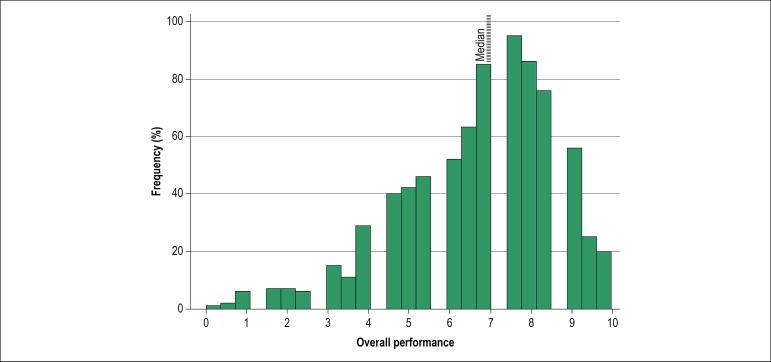
Frequency histogram showing the general score distribution obtained by the recently graduated physicians during practical assessment in the simulated station of STEMI medical care.